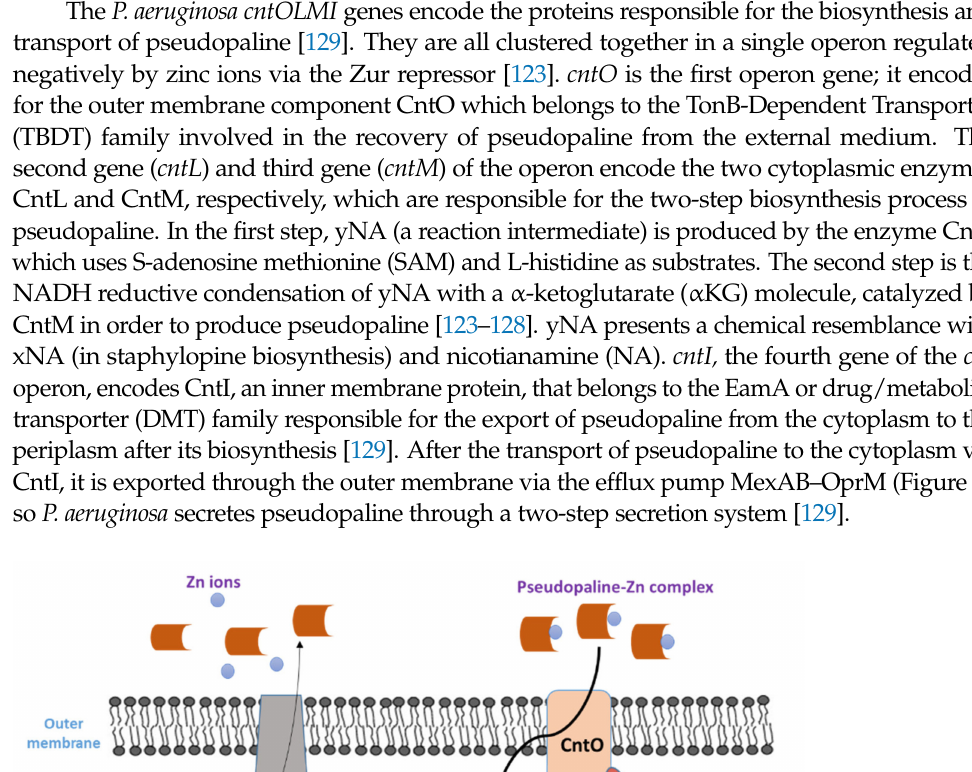
Figure 6. The structure of the opine-type metallophore in P. aeruginosa (pseudopaline). Pseudopaline Biosynthesis, Excretion, Import and Regulation